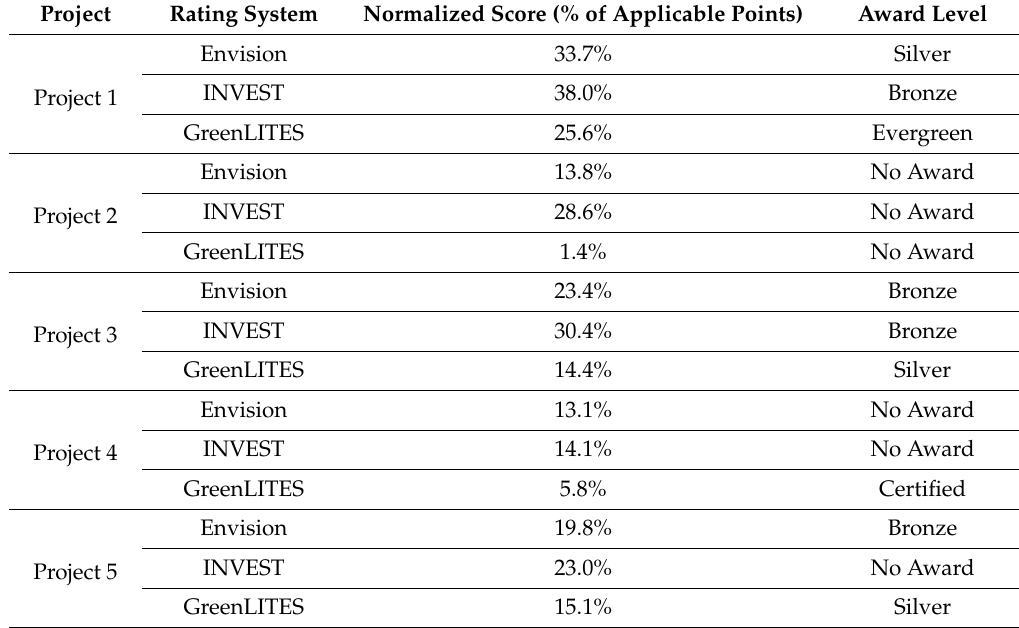
Table 3. All projects’ normalized scores and award levels on each rating